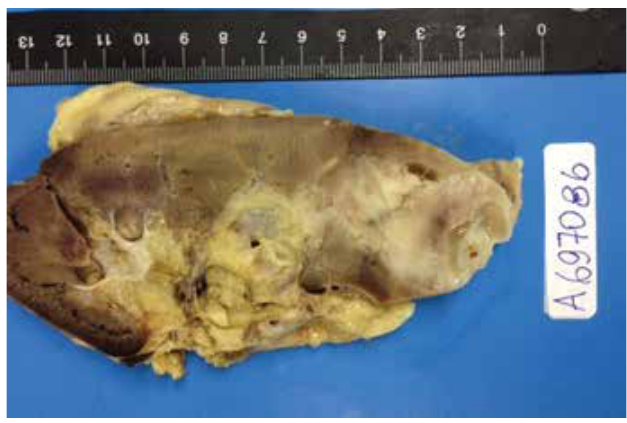
figuRE 1 − Mixed epithelial and stromal tumor of the kidney: a circumscribed, light brown, solid tumor, with cystic areas